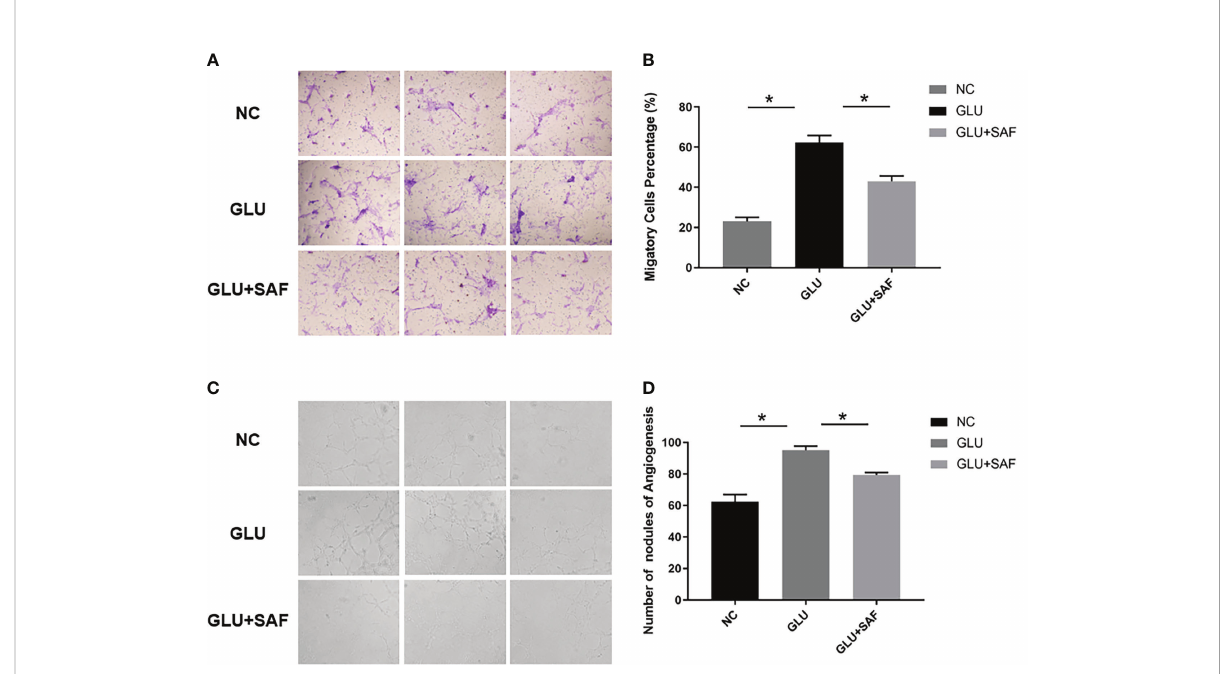
FIGURE 3 Cell migration and tube formation results. Under high glucose, more cells were found to migrate through the membrane. After safranal treatment, the migration rate decreased signi fi cantly P<0.001, (A, B) . There were more new vessel branches and nodes in the high glucose group but both decreased after safranal treatment P<0.001, (C, D) . * means a statistically signi fi cant